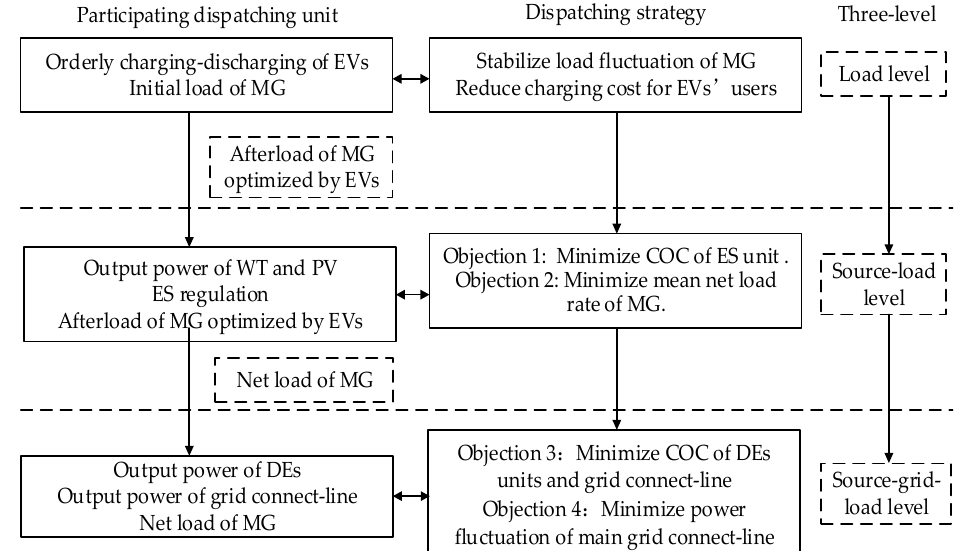
Figure 2. Structure of the multiobjective and hierarchical MG economic dispatch strategy.